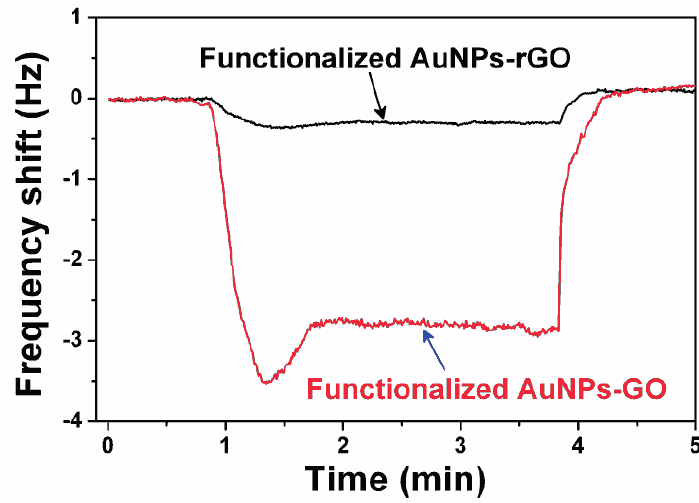
Figure 25. Under the same humidity change (by vaporizing injected water in the detection chamber), the sensor with the functionalized AuNPs-rGO sensing material shows a much lower response compared with the sensor loaded with the functionalized AuNPs-GO. Reprinted with permission from